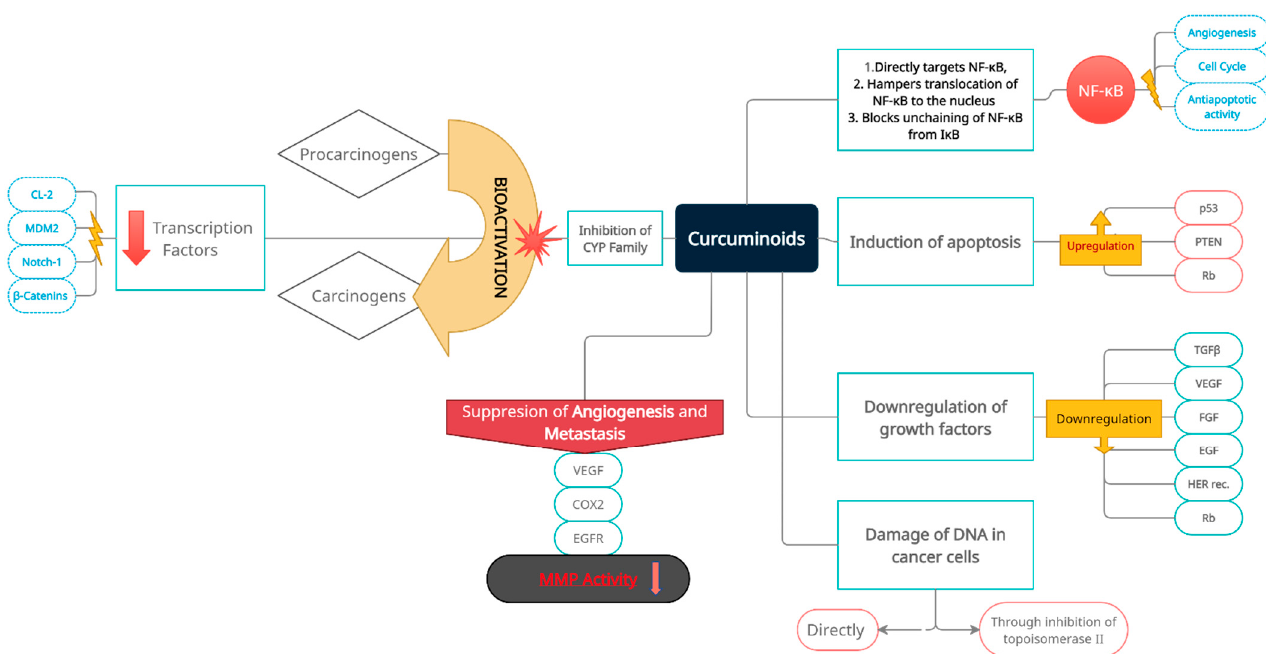
Figure 2. Multidirectional and multilevel preventive and inhibitory effects of curcuminoids on oncogenesis, with a special emphasis on induction and progression of bladder cancer, and its subsequent development. Prevention and inhibition of neoplastic transformation and progression is achieved through induction of apoptosis, inactivation of cancer-related transcriptional pathways (nuclear transcription factors and related oncogenes), cancer cell DNA damage (direct and indirect), inactivation of extracellular carcinogens, downregulation of growth factors, activation of cancer-suppressing genes, suppression of angiogenesis, and metastatic niche formation. Consecutive boxes of the diagram group intra- and extracellular molecular targets of curcumin.